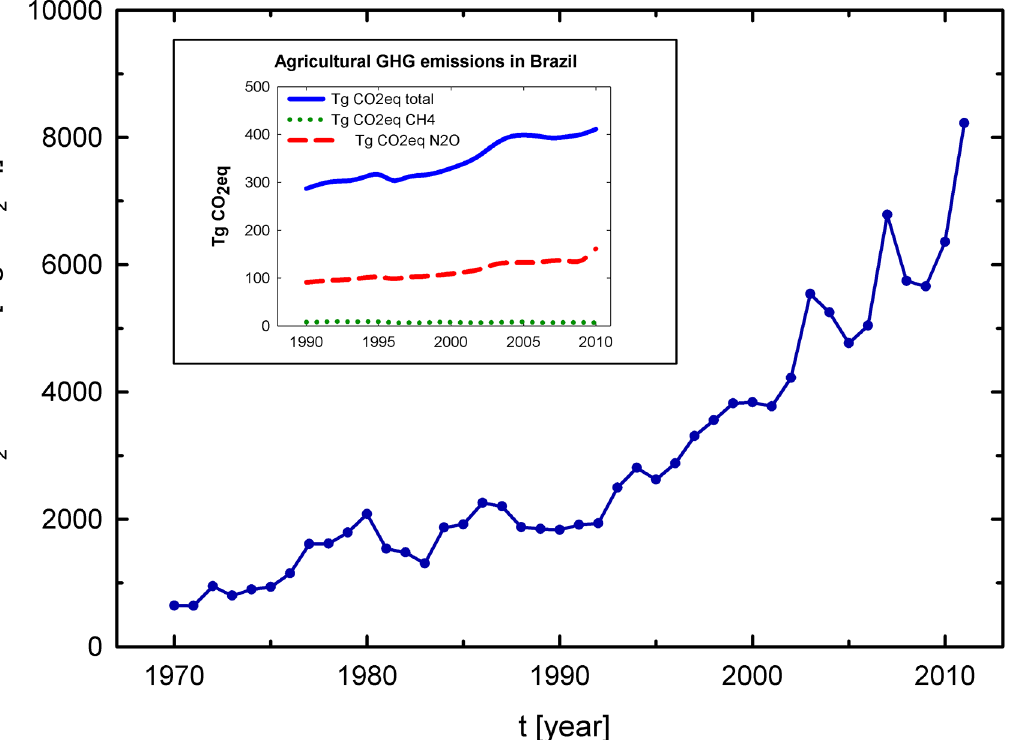
Fig 2. CO 2 eq. emission trends related to nitrogen fertilization from cereal production for Brazil, 1970 – 2011. CO 2 eq. emissions (1Gg = 1000 ton) from N fertilization data are based on the author ’ s calculation from the estimated model (Eq 2). The inset graph illustrates the agricultural GHG emissions in Brazil from 1990 to 2010 according to MCTI report [4].